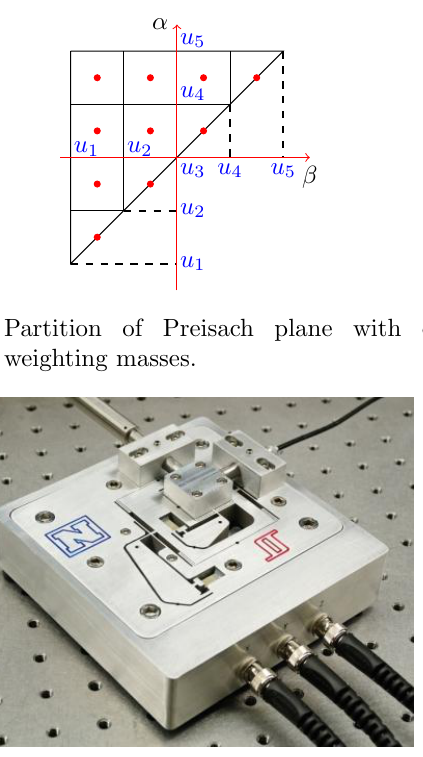
Figure 5: Nanopositioning stage.